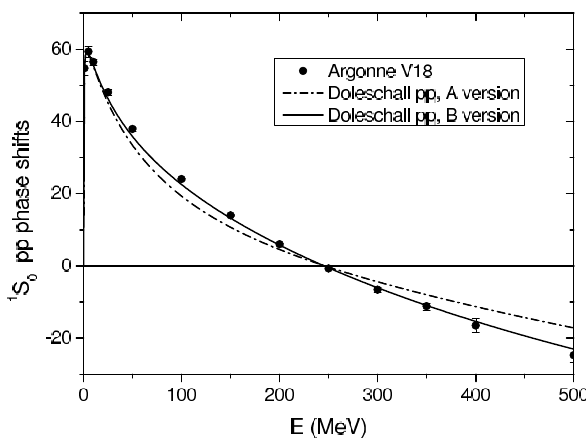
Fig. 4. 1 S 0 pp phase shifts for two versions of the NN poten- tial [27] (lines) in comparison with those of Argonne v 18 poten- tial (solid